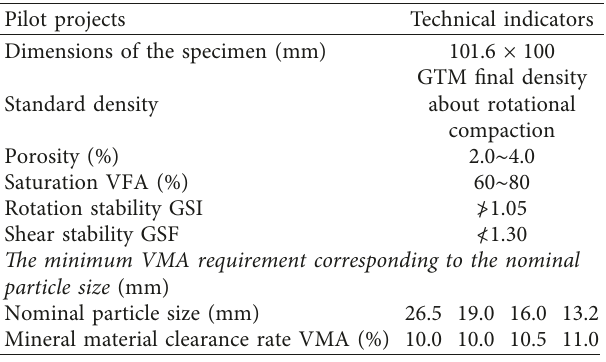
Table 5: Technical standards for an asphalt mixture designed by the GTM method